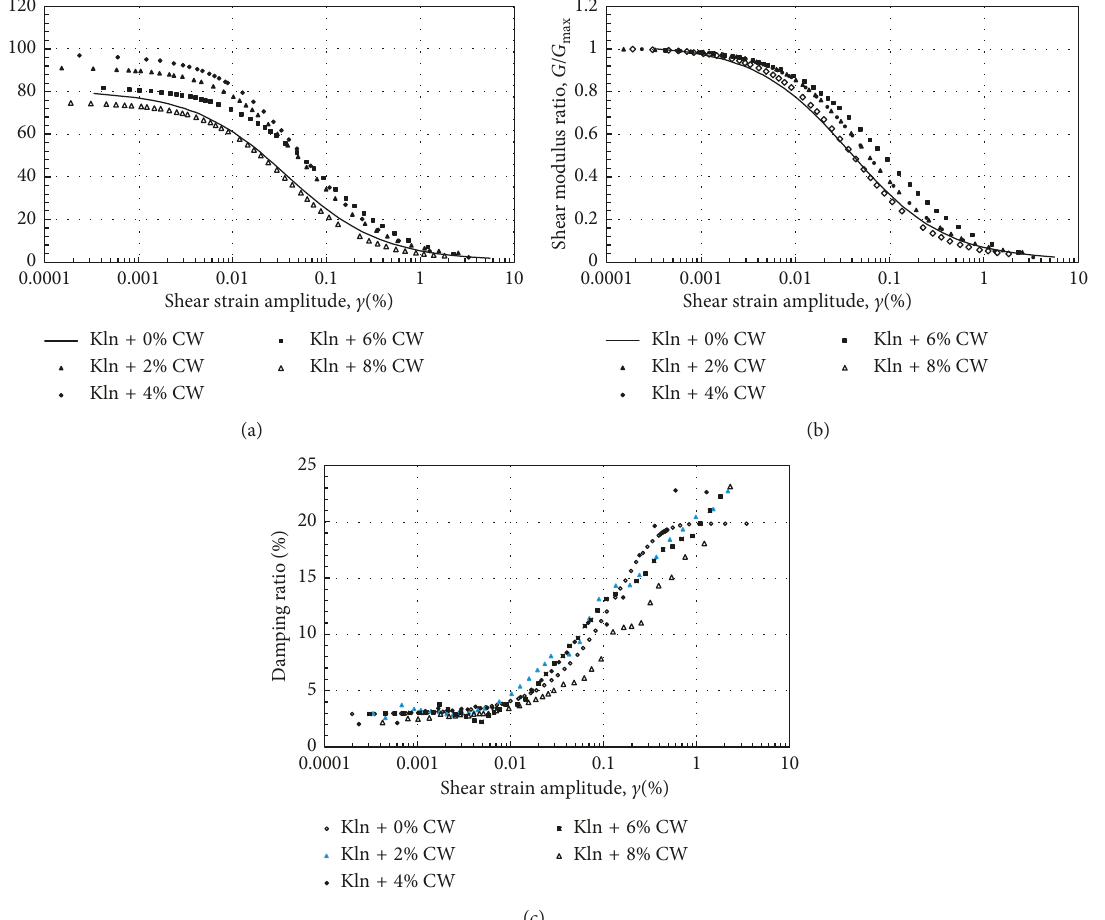
Figure 7: Comparison of (a) initial shear modulus, (b) shear modulus ratio, and (c) damping ratio of Kln+ CW